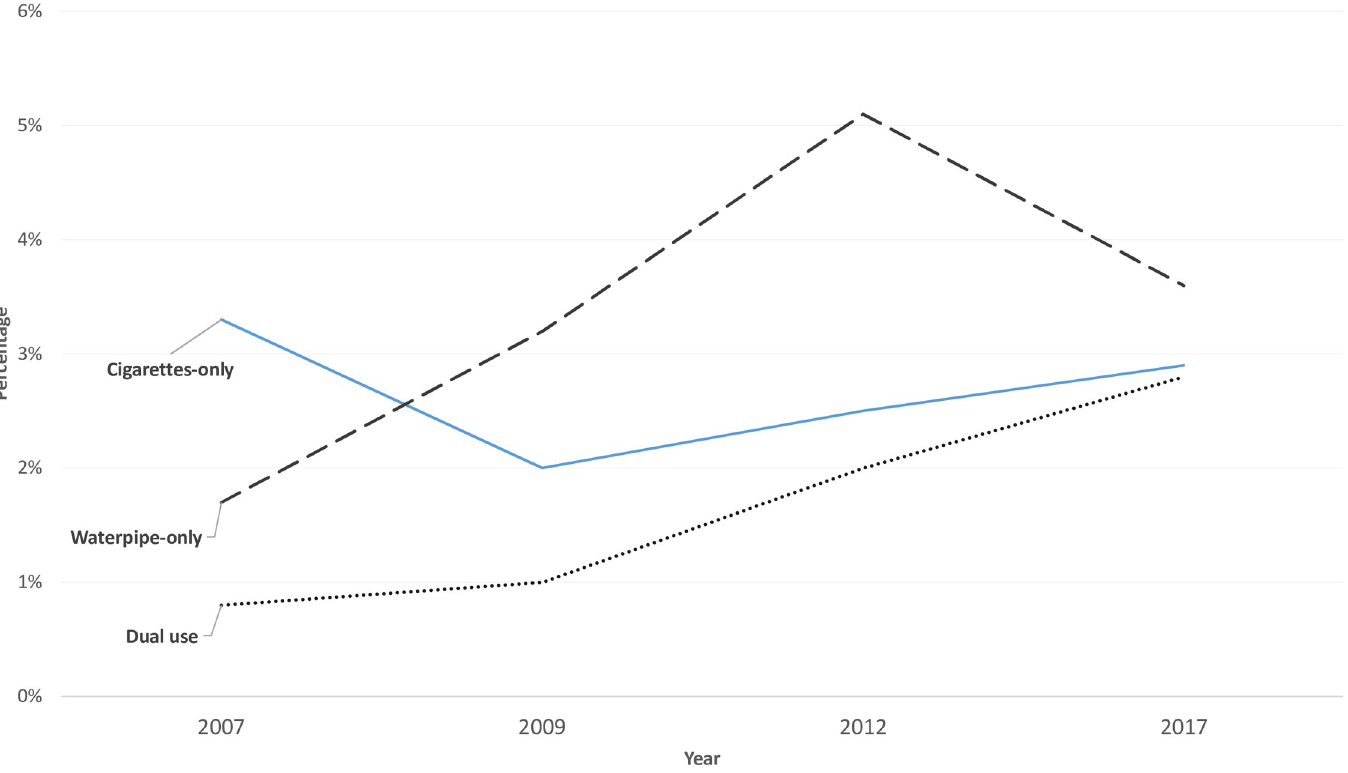
Fig 1. Prevalence estimates of cigarette-only, waterpipe-only, and dual use among ever-married pregnant women between 2007 and 2017.